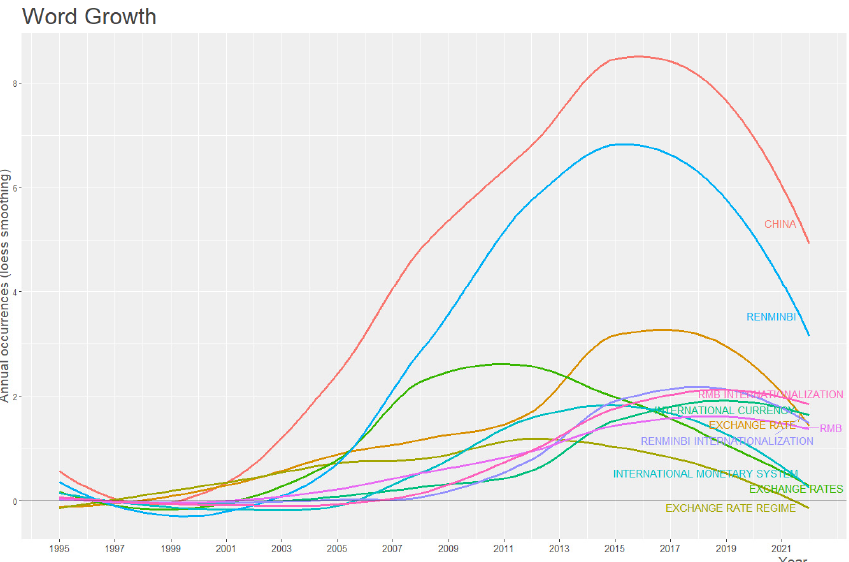
Figure 6. Word dynamics in authors’ keywords in 1995–2021. Source: Authors’ elaboration using Biblioshiny.